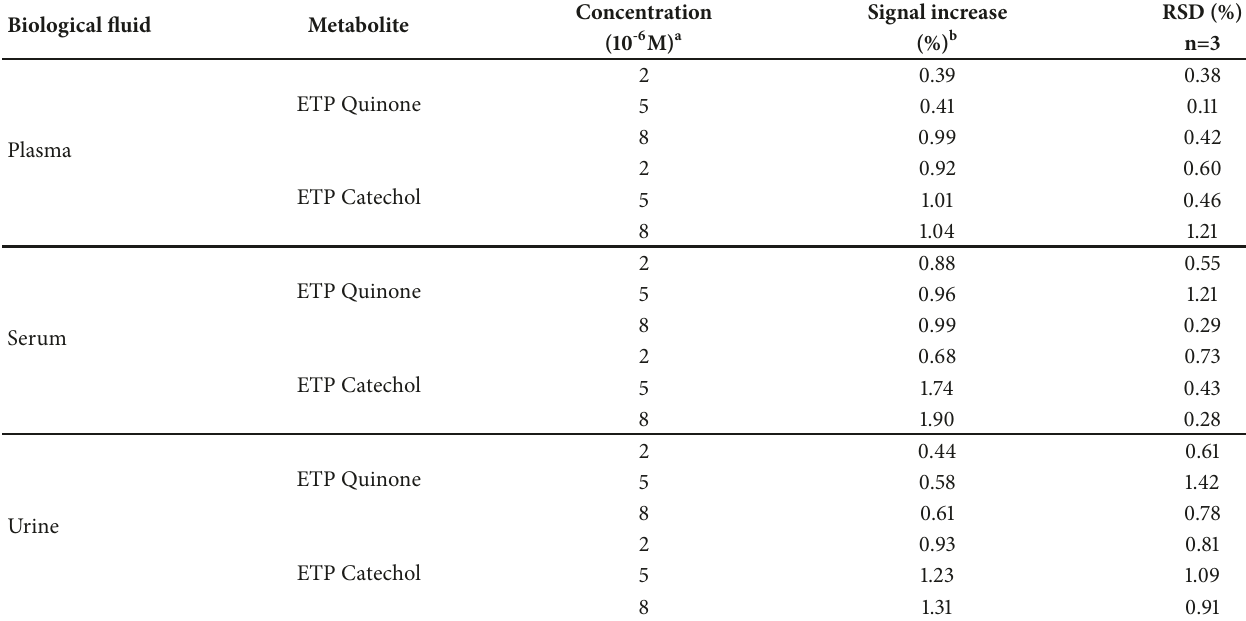
Table 2: Effect of metabolites on the differential pulse voltammetric response at the MIP/GCE sensor in biological human fluids. B iolo g ical fl uid